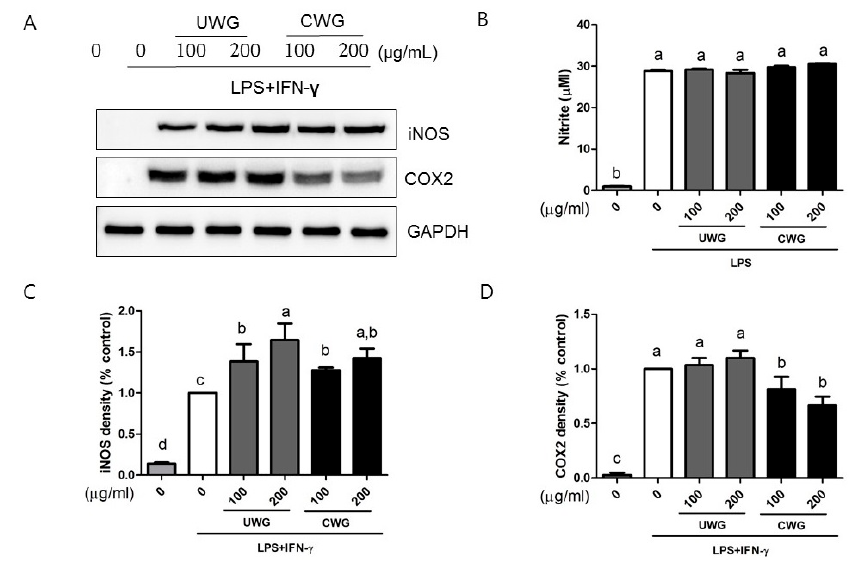
Figure 2. Effect of CWG on synthesis of inducible NO synthase (iNOS) and cyclooxygenase-2 (COX2). Mouse peritoneal macrophages were stimulated with LPS and interferon (IFN)- γ in the presence of UWG or CWG for 24 h. ( A ) The expression levels of iNOS and COX2 were analyzed by Western blotting using GAPDH as an internal control. One of three independent experiments is shown; ( B ) NO in the supernatant from LPS-stimulated RAW264.7 cells was measured by the Griess reaction ( n = 2). RAW264.7 cells were stimulated with LPS in the presence of UWG or CWG for 24 h; ( C , D ) The band intensity of iNOS or COX2 was normalized with GAPDH and percent control (LPS/IFN- γ stimulated cells) was shown ( n = 3). Different letters indicate statistical significances ( p < 0.05).